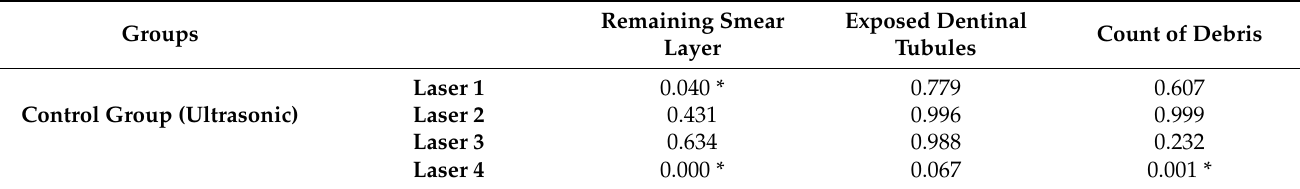
Table 2. Comparison of all laser groups to the control group in terms of remaining smear layer area, exposed dentinal tubules, and count of debris.